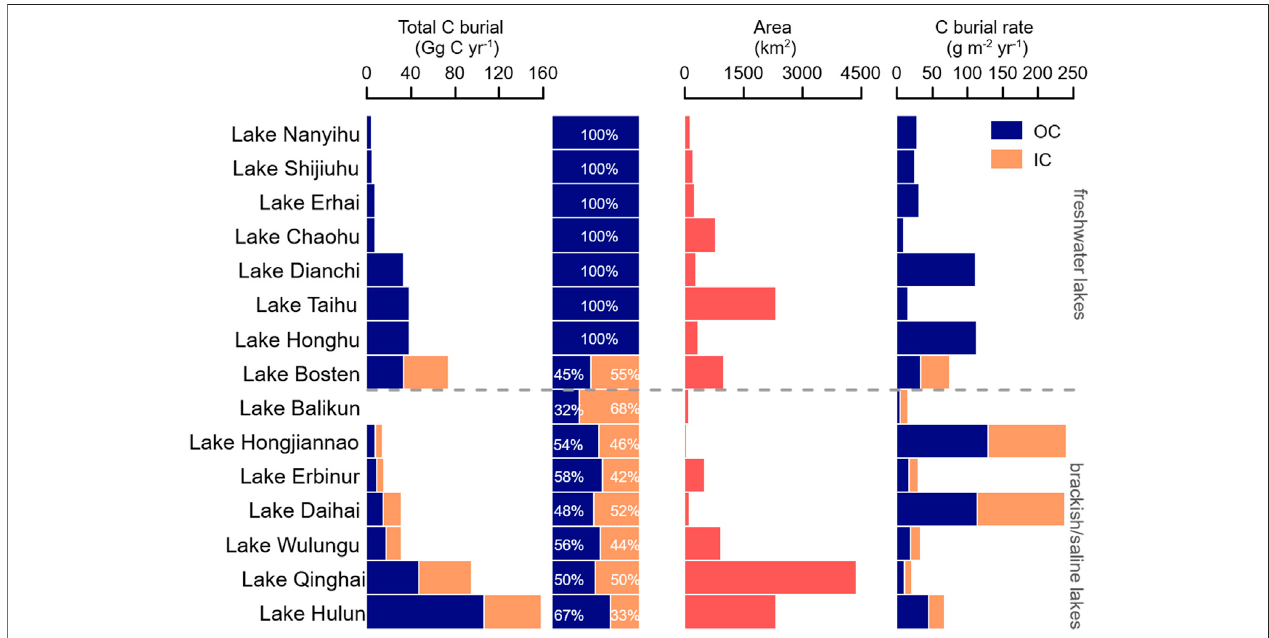
FIGURE 5 | Area, organic, and inorganic carbon burial rate of Lake Qinghai, Lake Balikun, Lake Hongjiannao, Lake Hulun, Lake Erbinur, Lake Daihai, Lake Wulungu,LakeBosten(Lanetal.,2015),LakeErhai(Liuetal.,2019),LakeDianchi(Huangetal.,2018),LakeShijiuhu,LakeTaihu,LakeHonghu,LakeNanyihu(Guietal., 2012), and Lake Chaohu (Dong et al., 2012). Total C burial was calculated by multiplying carbon burial rates with lake